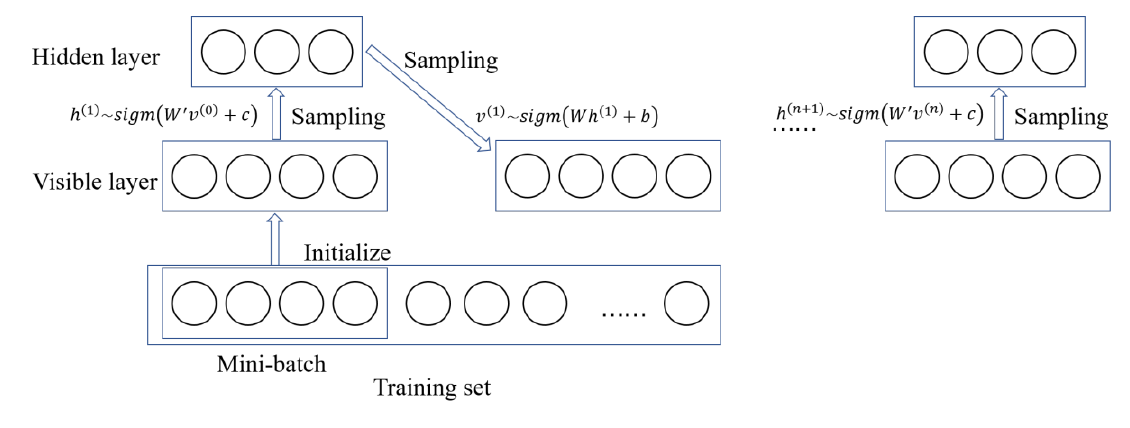
Figure 6. Gibbs Figure 6. Gibbs sampling.